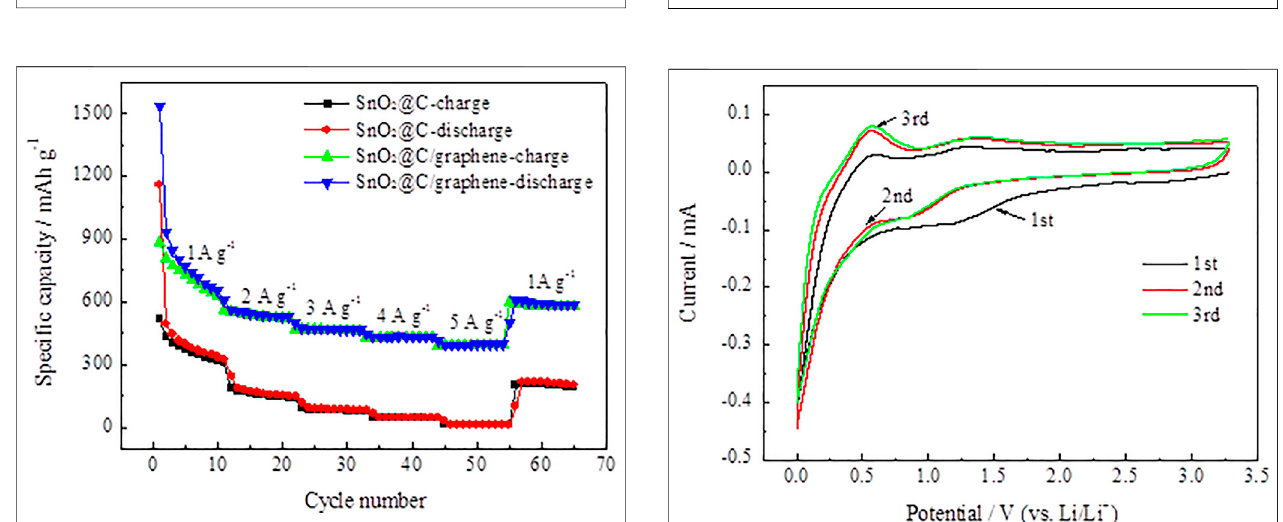
FIGURE 9 | Cycle performances of carbon spheres/graphene, SnO 2 / graphene, SnO 2 @C, and SnO 2 @C/graphene at a current density of 1,000 mA g − 1 .